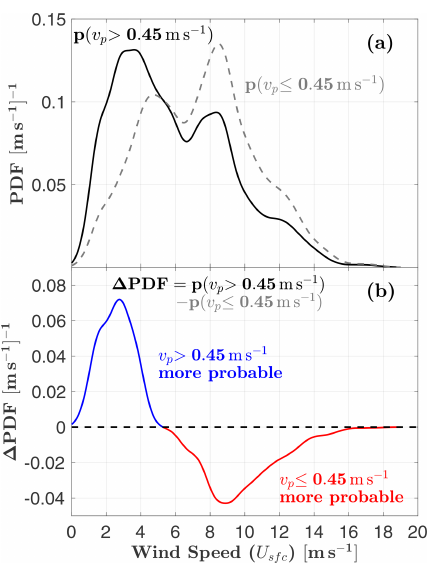
Figure 4. (a) Comparison of, and (b) difference between, estimates of surface wind speed U sfc PDFs for the high ( v p > 0 . 45ms − 1 ) and low ( v p ≤ 0 . 45ms − 1 ) fall speed modes of the shielded MASC fall speed distribution from Fig. 3. (cid:49) PDF > 0 means the probability of v p > 0 . 45ms − 1 is greater.